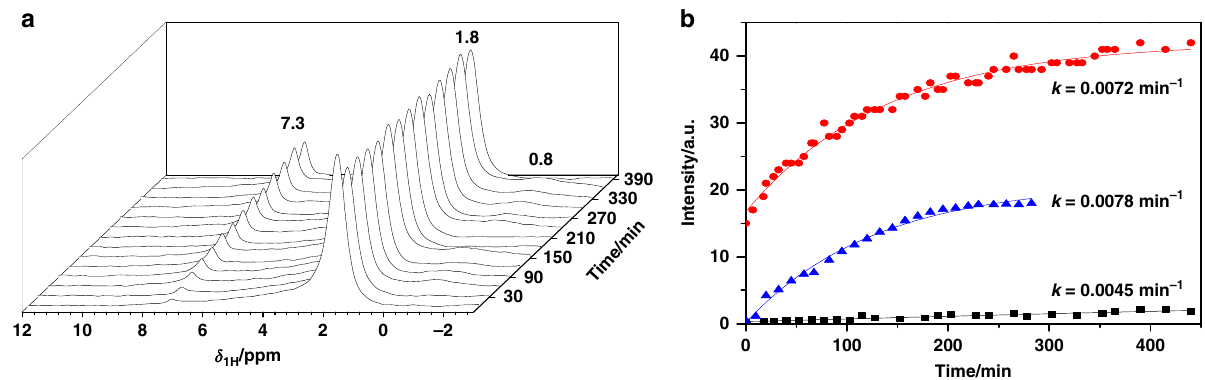
Fig. 5 Catalytic performance of ASA in H/D exchange with C 6 D 6 . 1 H MAS spectra recorded at 9.4 T of dehydrated catalysts, a stack plot spectra recorded during H/D exchange of C 6 D 6 loaded over dehydrated SA/50 at 313 K, with a loading of one benzene molecule per BAS; b Kinetics and H/D exchange rates k between deuterons bound to the aromatic rings of C 6 D 6 (99.6 %) and BAS at 313 K in H-ZSM-5 (top), SA/50 (middle) and SA/10